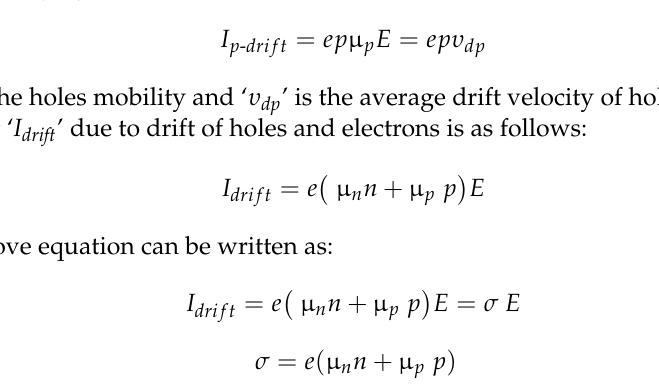
Figure 5. The PV cell under illumination.